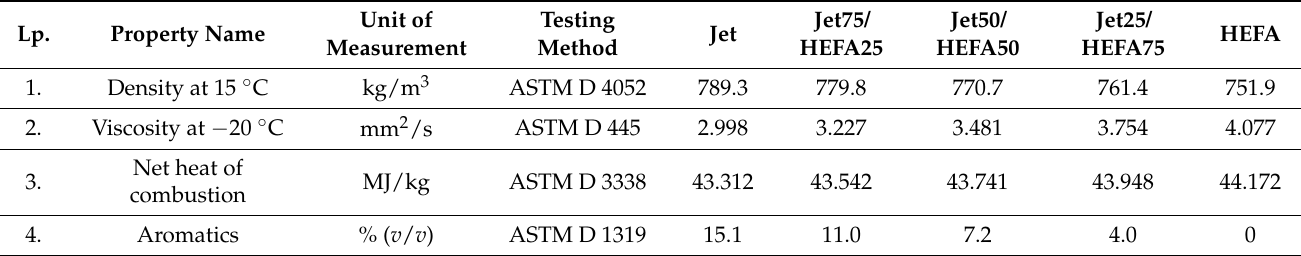
Table 2. Selected physicochemical properties of Jet A-1, HEFA component and their blends. Lp.